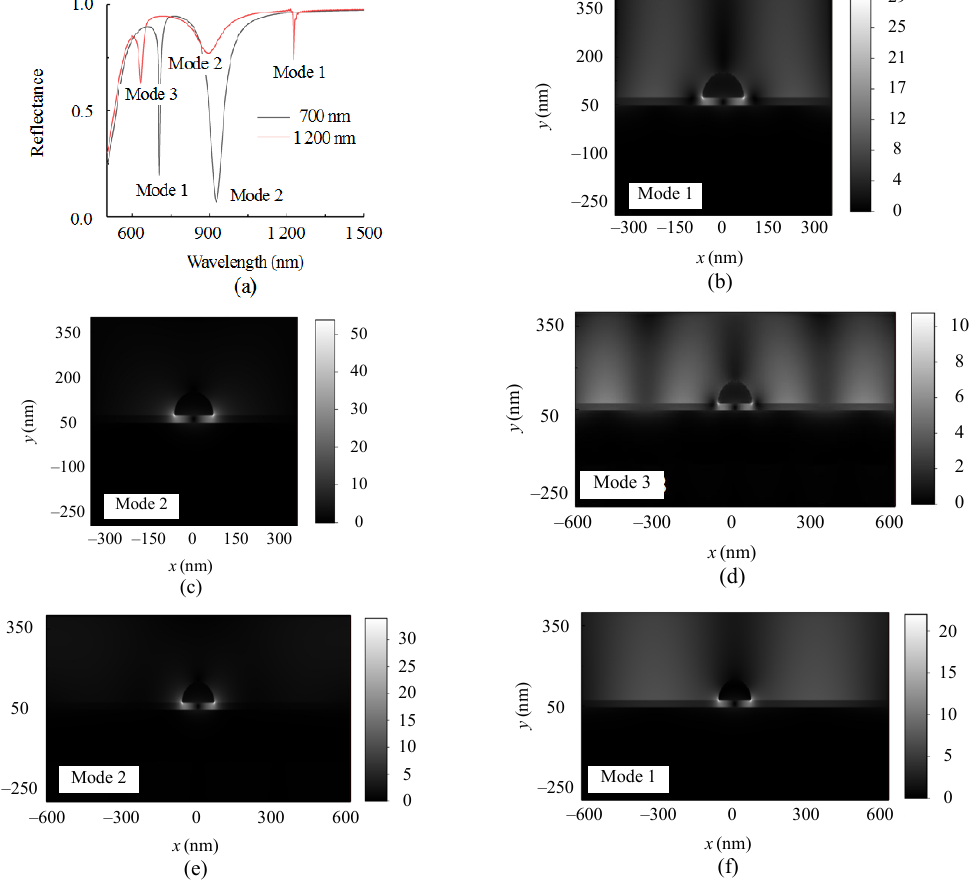
Fig. 3 Plasmonic responses of the 1D grating composite structure: (a) reflection spectra of the 1D grating composite structure with periods of 700 nm and 1 200 nm, respectively. Electric field distribution | E | / | E 0 | at the resonance wavelength of (b) Mode 1 and (c) Mode 2 with a period of 700 nm, and at the resonance wavelength of (d) Mode 3, (e) Mode 2, and (f) Mode 1 with a period of 1 200